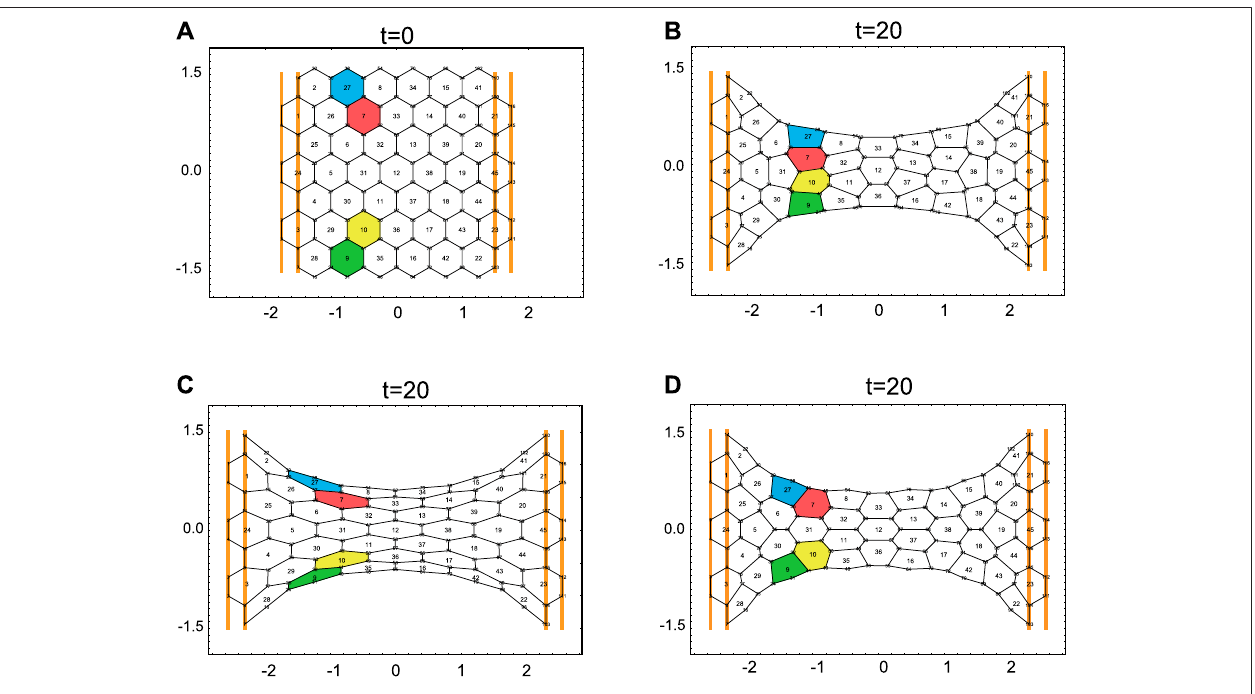
FIGURE3 | (A) The initial con fi guration of thecell sheet.At time t (cid:1) 0, the cell sheet begins to be stretched by externalforces, which are represented bythe orange bars. At these bars, the cell boundaries are fi xed, and the bars are shifted with time (for the movement of the bars see Supplementary Movies 3 – 5 ). (B) The fi nal cell con fi guration of the sheet stretched by external forces. The cell sheet dynamics are implemented by the previous vertex model (see Supplementary Appendix 1 ). The time evolution equation for r i is given by _ r i (cid:1) −(( 1 / (cid:16) η )) z U / z r i , where (cid:16) η is a constant. The parameter values used here are K (cid:1) 1, A ( 0 ) α (cid:1) 0 . 22, (cid:16) c ij (cid:1) 1 . 0. (cid:16) η (cid:1) 1 . 0, L 0 (cid:1) 1 . 65, and K p (cid:1) 50. (C) The fi nal cell con fi guration of the sheet stretched by the external forces. The cell sheet dynamics are implemented by the present vertex model.Theparametervaluesusedhereare K (cid:1) 1, A ( 0 ) α (cid:1) 0 . 22, c ij (cid:1) 1 . 0, η (cid:1) 0 . 01, L ( 0 ) α (cid:1) 1 . 65, k pm (cid:1) 50, k (cid:1) 100,and1 / τ ij (cid:1) 0. (D) The fi nalcellcon fi gurationofthesheet after being stretched by external forces using the present vertex model with fi nite τ ij (cid:1) 0 . 1. The other parameter values are the same as those in (C)